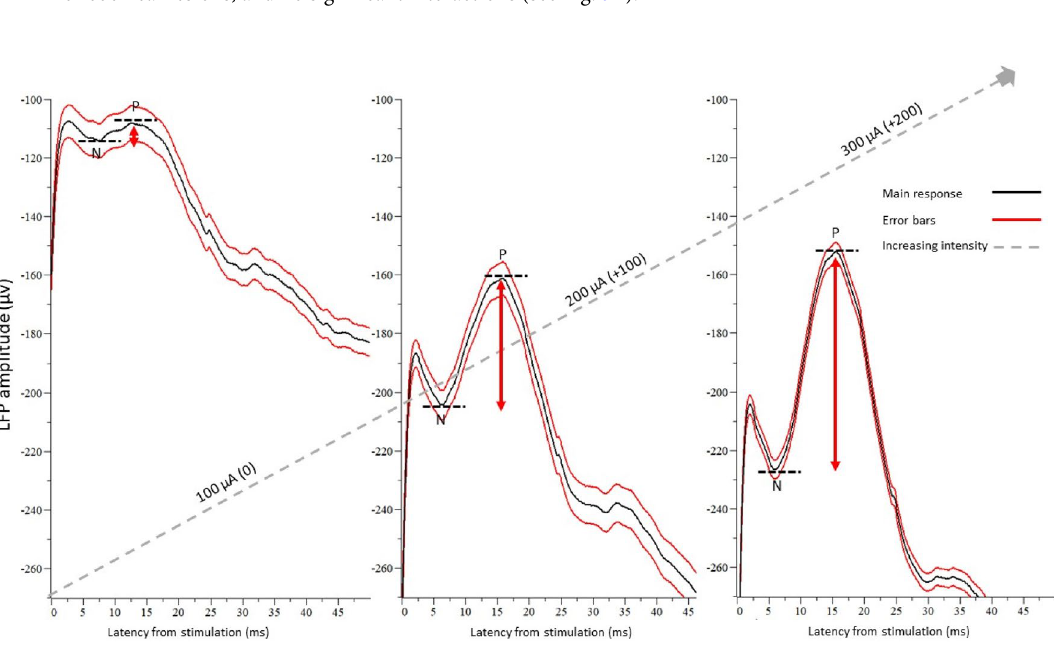
Figure 2. Example of the evoked LFP responses after increasing intensity of electrical stimulation. The LFP recording was configured so that it was triggered by the last pulse of the stimulation for all 50 trains of stimulation. The traces represent an average of 50 sweeps ± 1